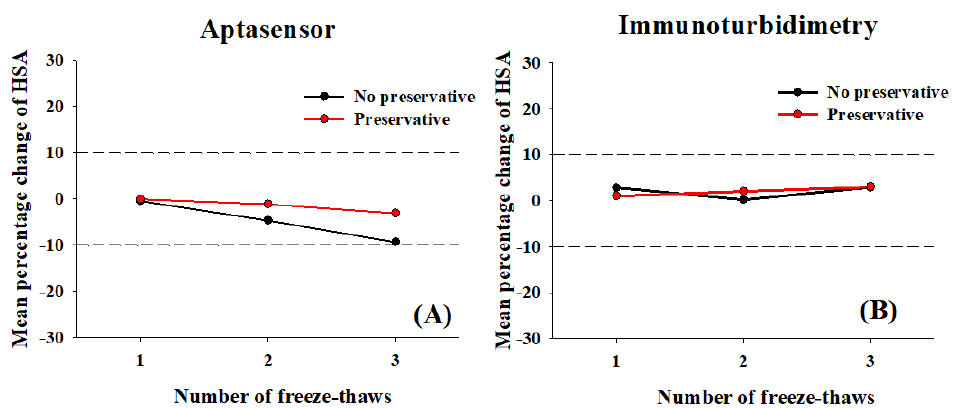
Figure 8. Mean percentage change in microalbumin concentrations, as determined by GO-based fluorescent detection or using the aptasensor ( A ) and by immunoturbidimetry ( B ) assays with and without 2% ( w / v ) boric acid following freeze–thaw cycles (1, 2, and 3 cycles). Dashed lines indicate ± 10% change from the initial day 0 value.